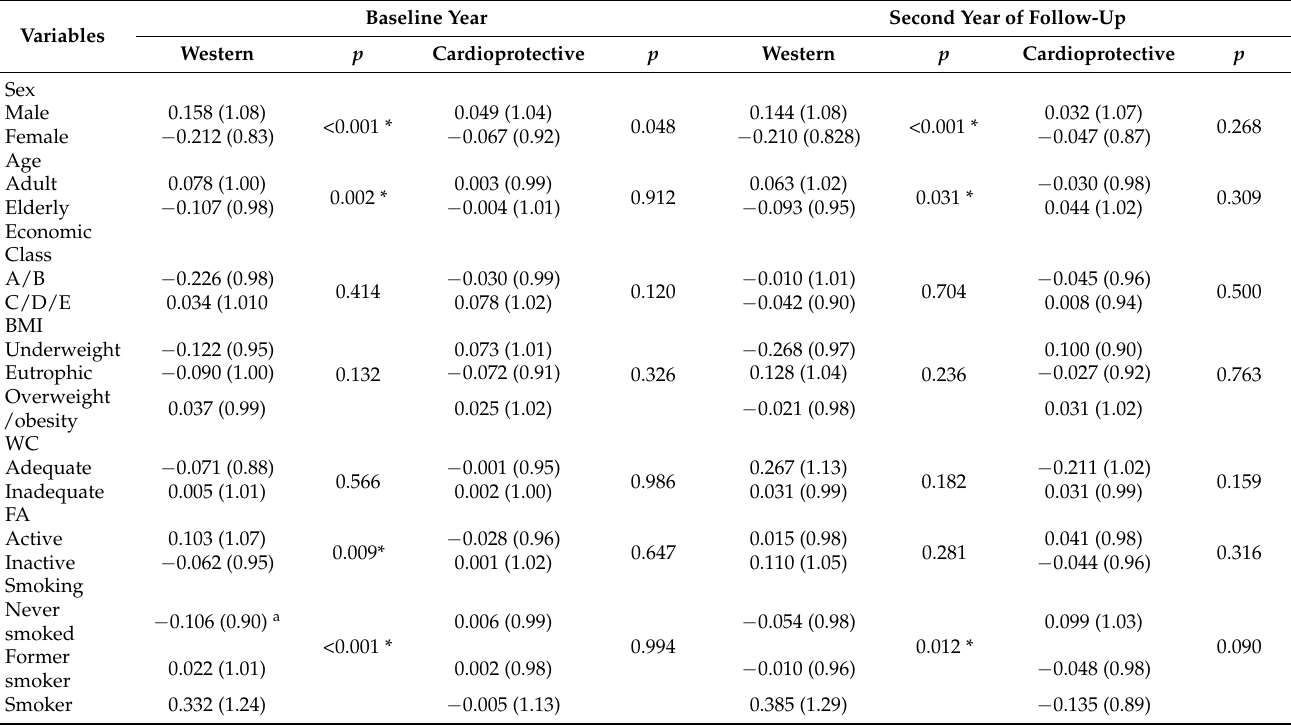
Table 6. Food patterns of the control group according to socioeconomic, nutritional status and lifestyle characteristics in the base year and in the second year of follow-up of the BALANCE program.